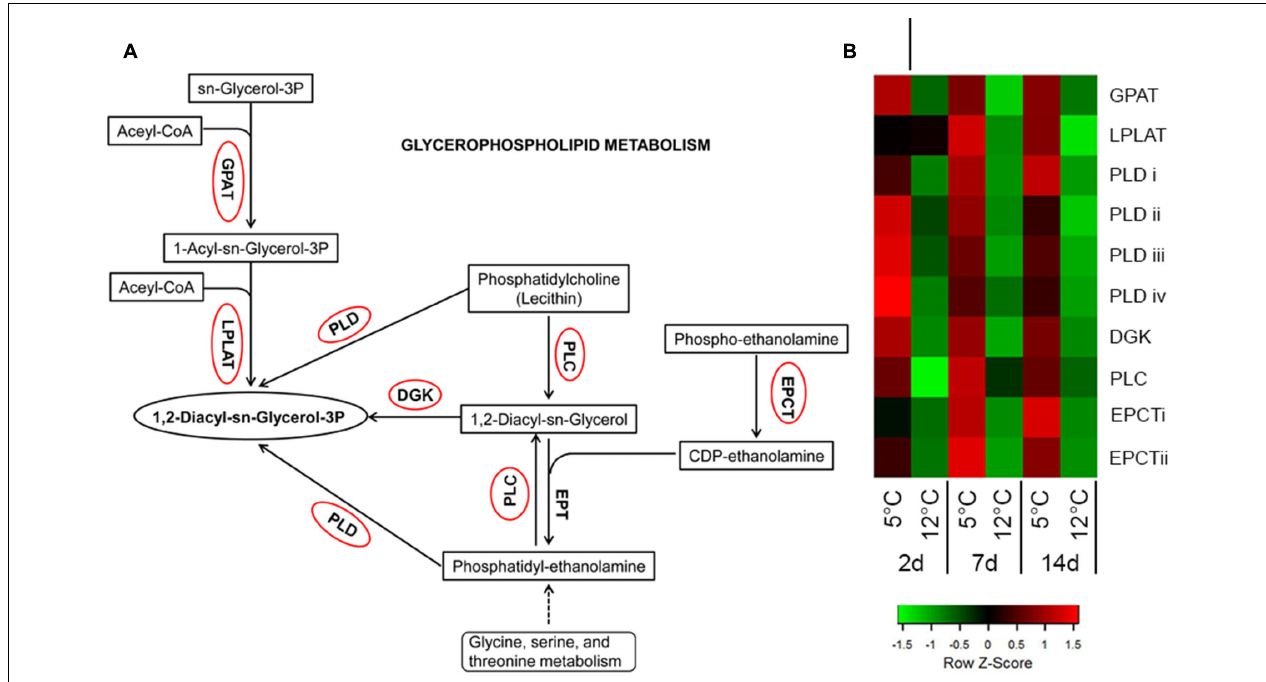
FIGURE 9 | Activation of glycerophospholipid metabolism-related genes in response to cold storage. (A) Glycerophospholipid metabolism based on the KEGG pathway mapper. Genes circled in red are significantly upregulated during cold storage at 5 ◦ C. (B) Expression heat map of genes related to glycerophospholipid metabolism at two different storage temperatures (5 and 12 ◦ C) at different sampling times (2, 7, and 14 days). Z -scores represent rescaled log fold change values. Abbreviations, transcript identification and expression profile are described in Supplementary Table S2